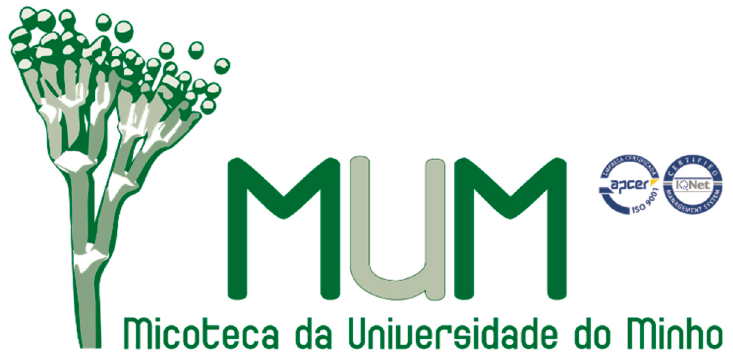
Figure 3. Logo of certified organisation by Associação Portuguesa de Certificação (APCER).